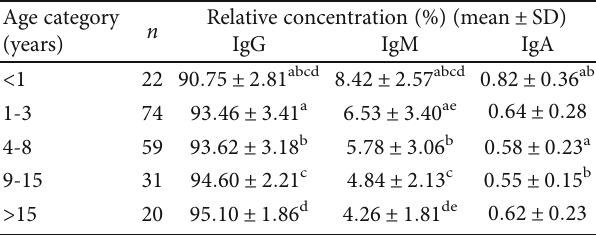
Table 3: Mean ( ± SD) relative concentration (%) of IgG, IgM, and IgA (%) in serum of apparently healthy European bison of various